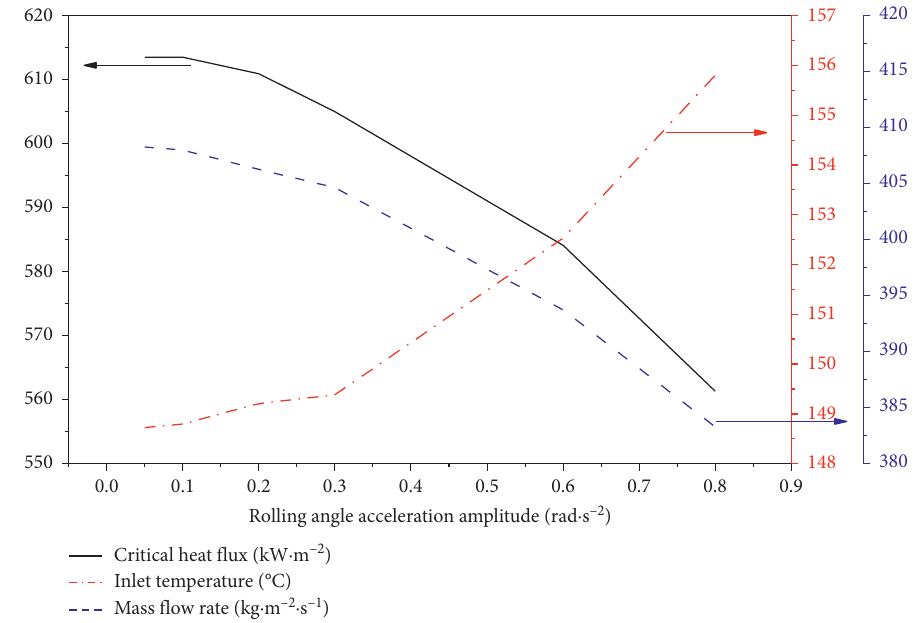
Figure 17: Influence of rolling angle acceleration amplitude on CHF, T � 4.5s.